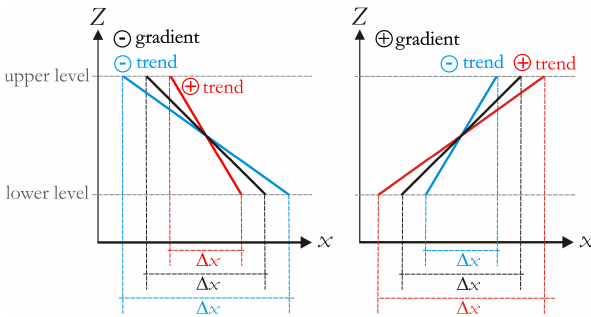
Fig. 8. Schematic illustration of negative and positive variable gra- dient (upper level value minus lower level value) and its